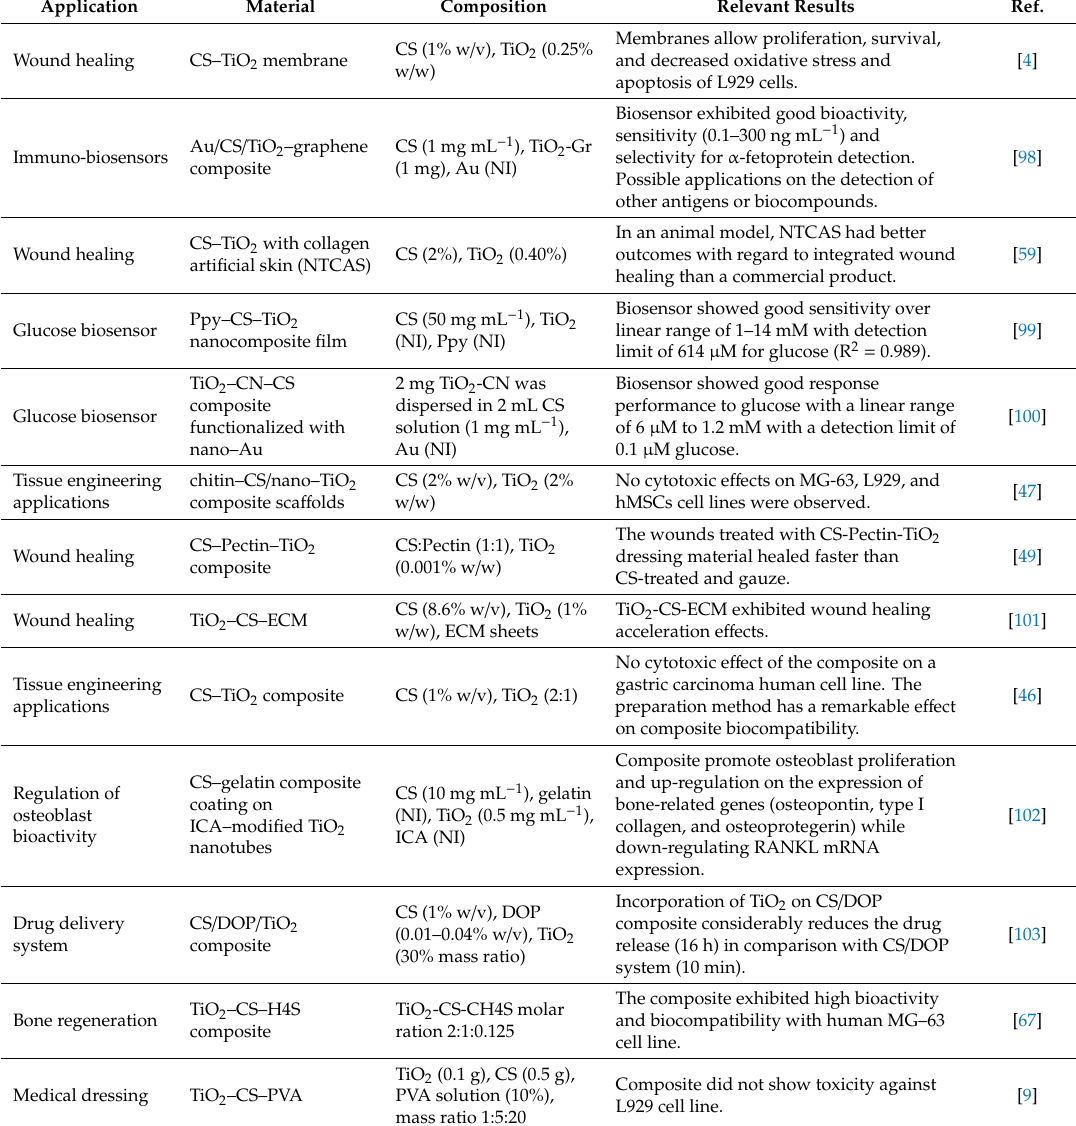
Table 6. Potential biomedical application of a CS–TiO 2